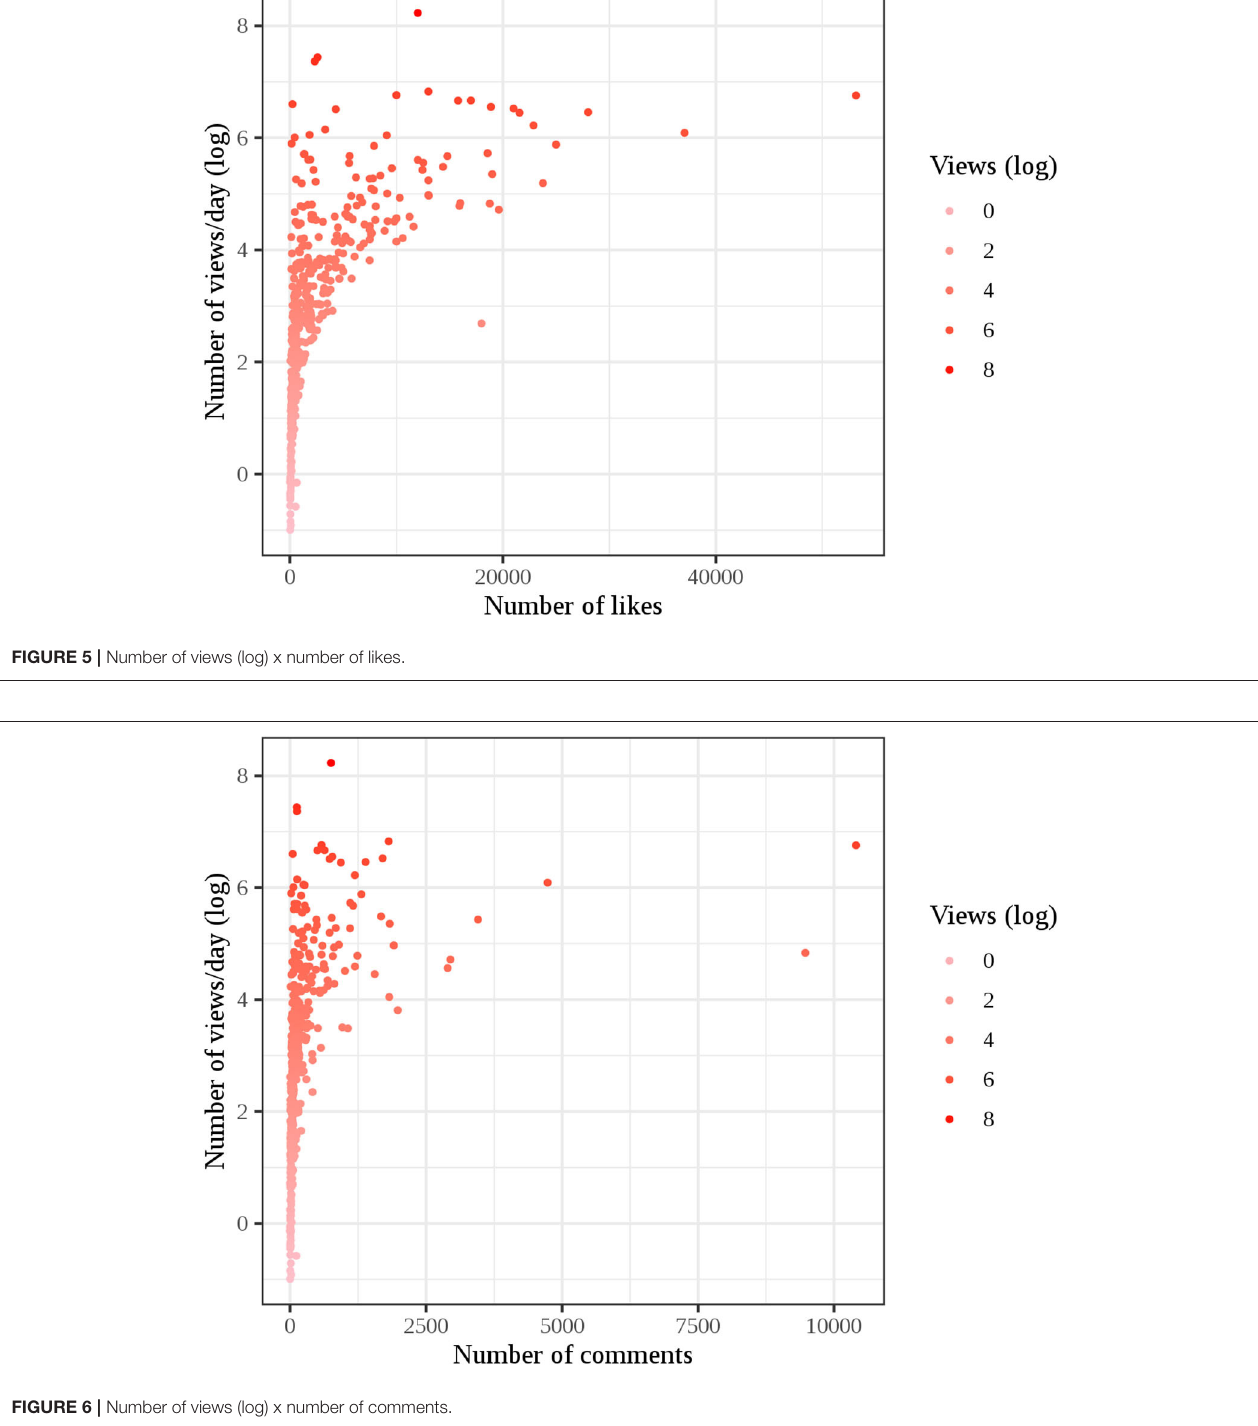
FIGURE 6 | Number of views (log) x number of